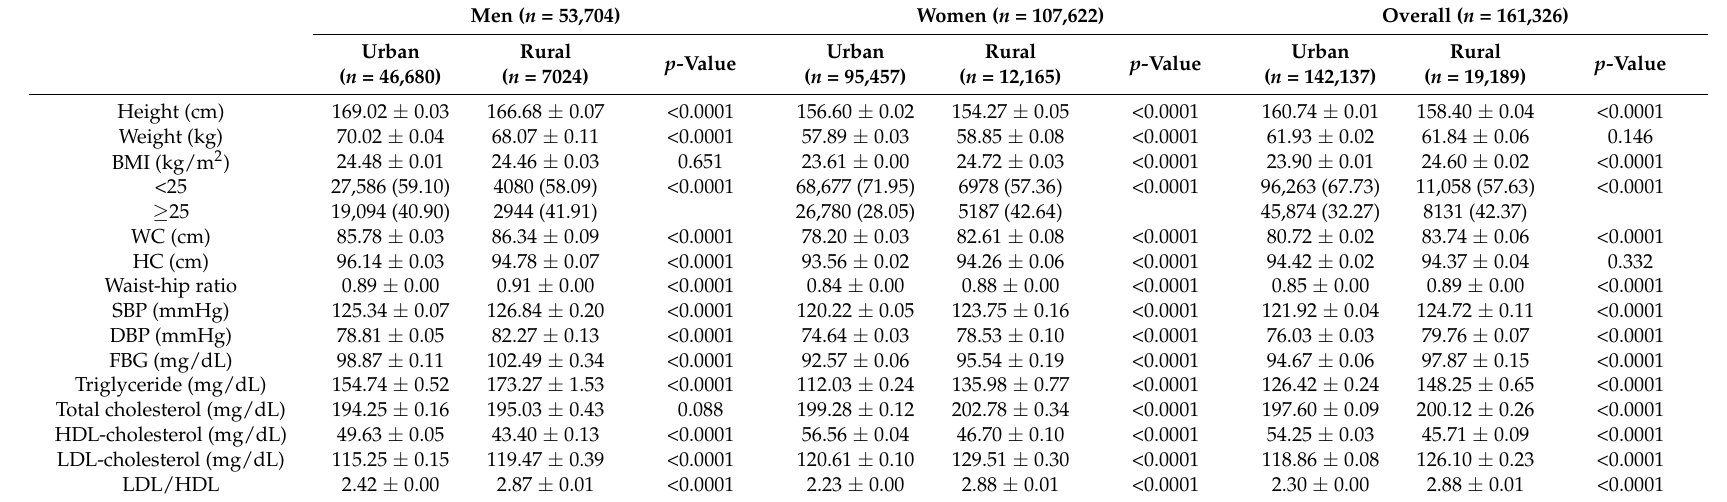
Table 2. Anthropometric parameters, blood pressure, and blood profiles of rural and urban Korean